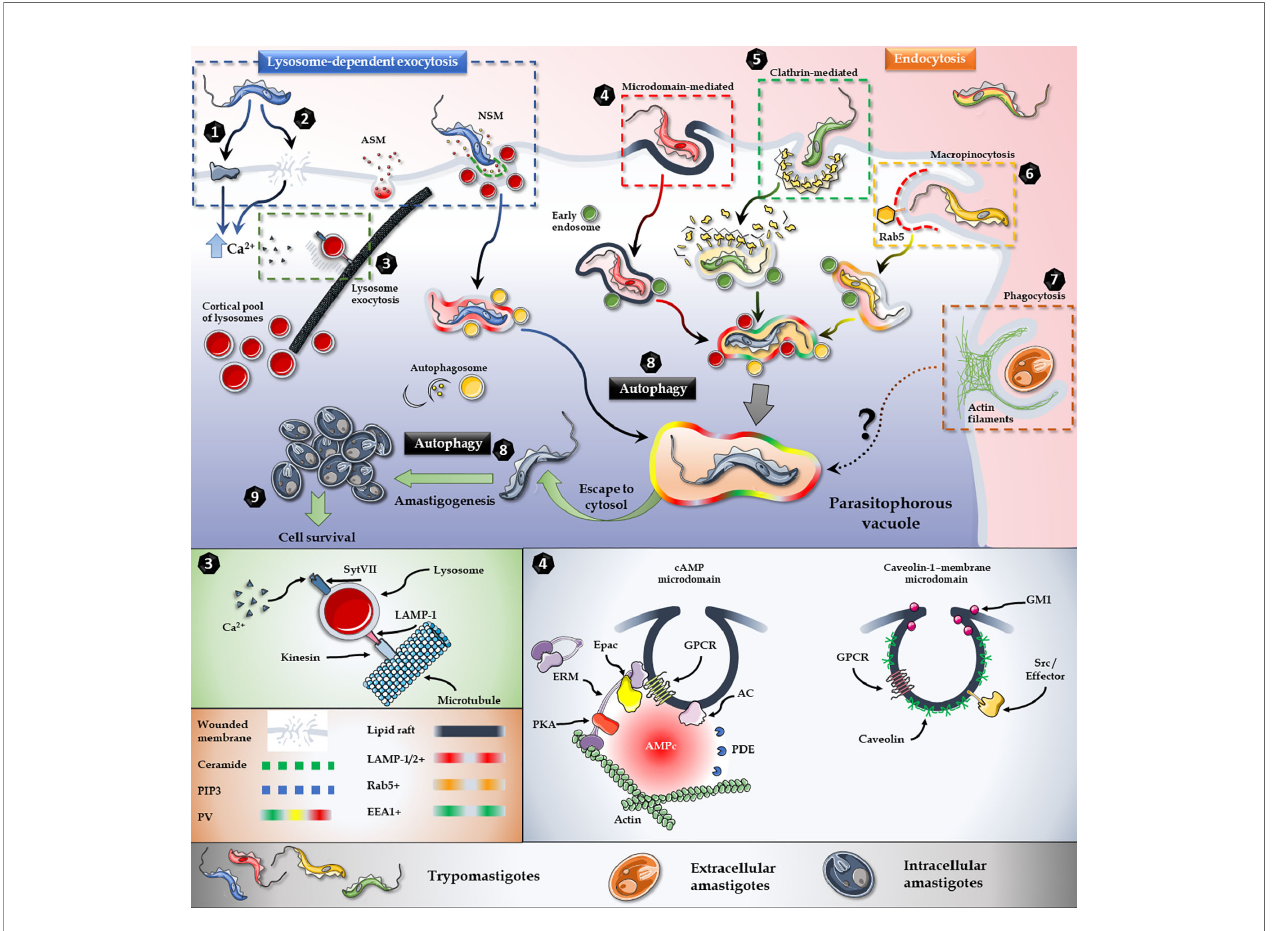
FIGURE 2 | T. cruzi invasion model. Lysosome exocytosis involves surface/secreted proteins (1) or micro-injuries (2) that trigger an elevation in the intracellular levels of Ca2+ and the microtubule/kinesin-mediated recruitment of lysosomes from surrounding areas to the parasite entry site (3). Host ’ s Acid Sphingomyelinase (ASM) and a parasite Neutral Sphingomyelinase (NSM) are secreted to the extracellular milieu and participates in the breakdown of sphingomyelin to ceramide and phosphorylcholine in the outer lea fl et of the plasma membrane (3). Endocytic mechanisms, such as lipid raft-dependent endocytosis (4), clathrin-mediated endocytosis (5) and macropinocytosis (6) also converge in the internalization of the parasite. Extracellular amastigotes, on the other hand, employ a phagocytosis-like mechanism for invasion (7). Moreover, autophagy is a key player during the invasion and also promotes trypomastigotes to amastigotes differentiation (8). In brief, regardless of the parasite stage, or the activated cascade, all internalization pathways culminate in the parasitophorous vacuole, from which parasite escapes to the cytoplasm and differentiates into amastigotes and proliferates (9). Figures were created using images from Servier Medical Art Commons Attribution 3.0